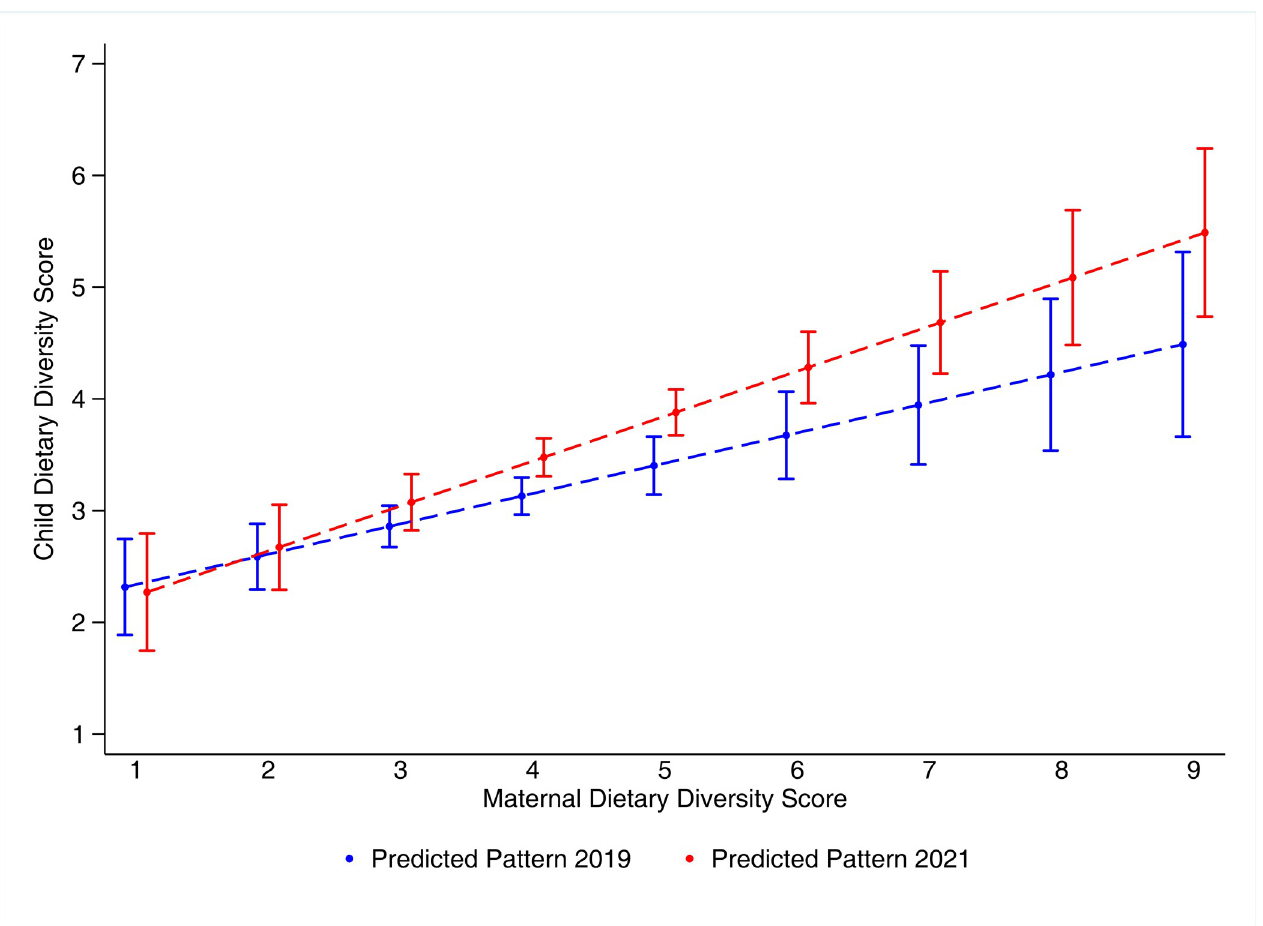
Fig 3. Association between number of food group intake among mothers and children (6–23 months), Gadchiroli and Chandrapur, 2019 and 2021.